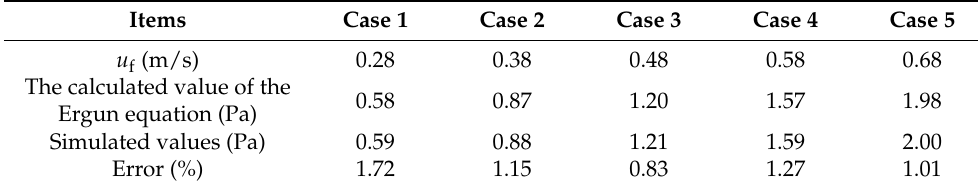
Table 4. Comparison of pressure drop with different gas velocities from the Ergun equation and simulations.